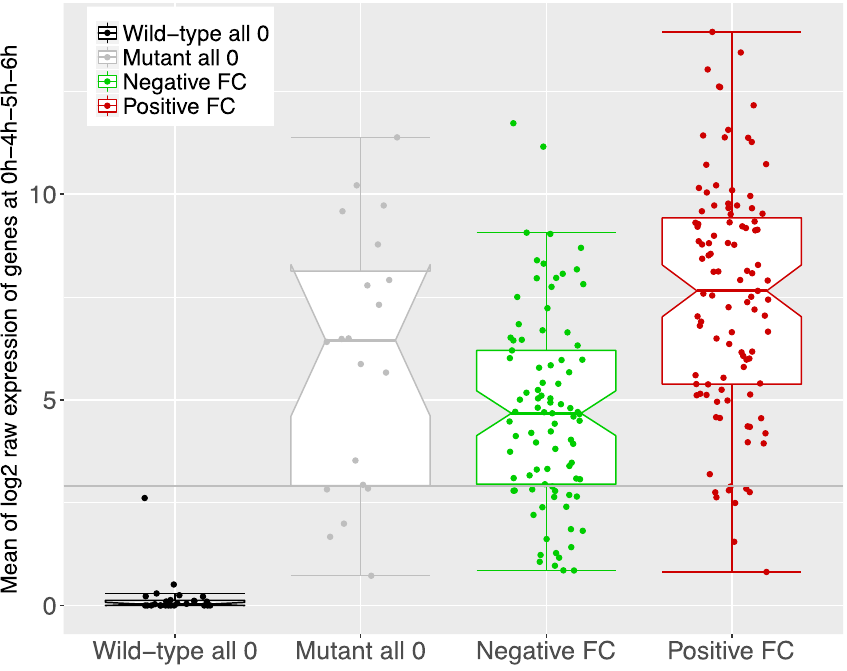
Figure 4. Mean of log2 raw expression of genes at 0 h, 4 h, 5 h, and 6 h based on the global basal mean expression using the transcriptomic data for different groups of proteins identified in proteomics. From left to right, group of coding genes that were identified in the proteome of glkA null cells but not in the proteome of wild-type cells (Wild-type all zero); group of coding genes that were identified in the proteome of AX2 cells but not in the proteome of glkA null cells (Mutant all zero); group of coding genes found significantly differentially expressed, either downregulated (Negative FC) or upregulated (Positive FC). FC stands for fold-change.